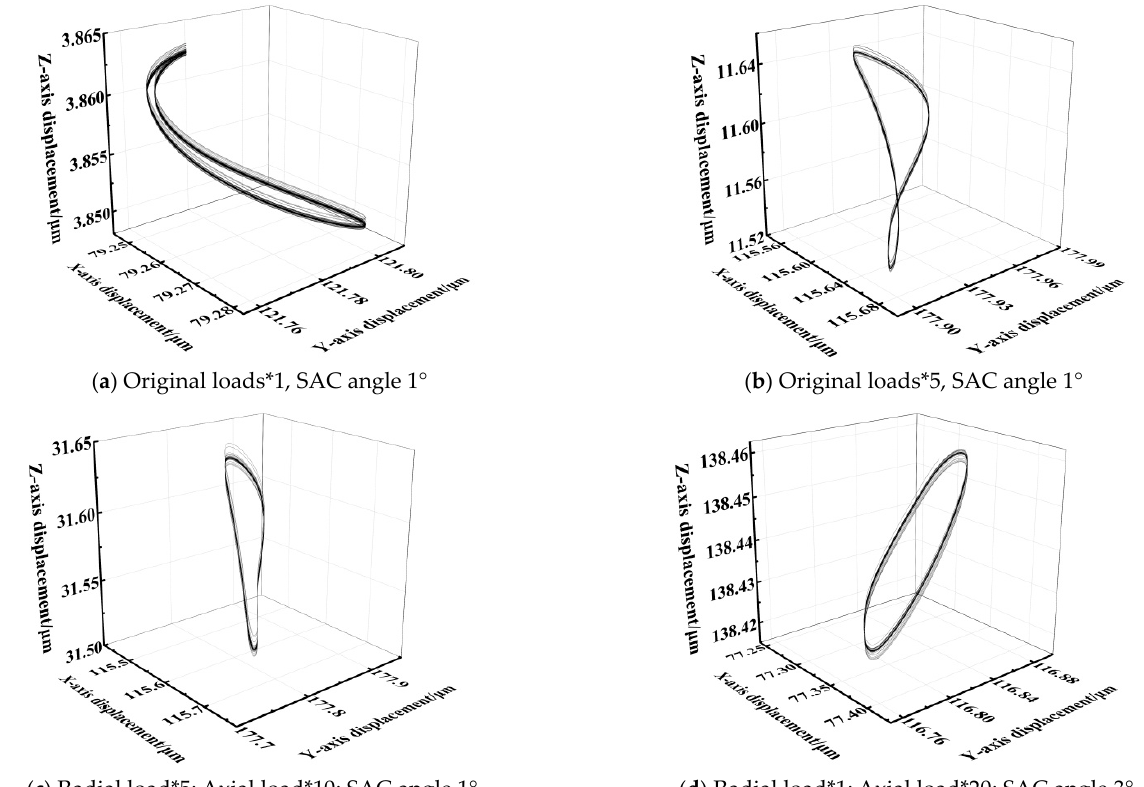
Figure 18. The motion orbit of the inner ring with a rotating speed of 1200 rpm under the heavy ‐ load and self ‐ aligning operating conditions.